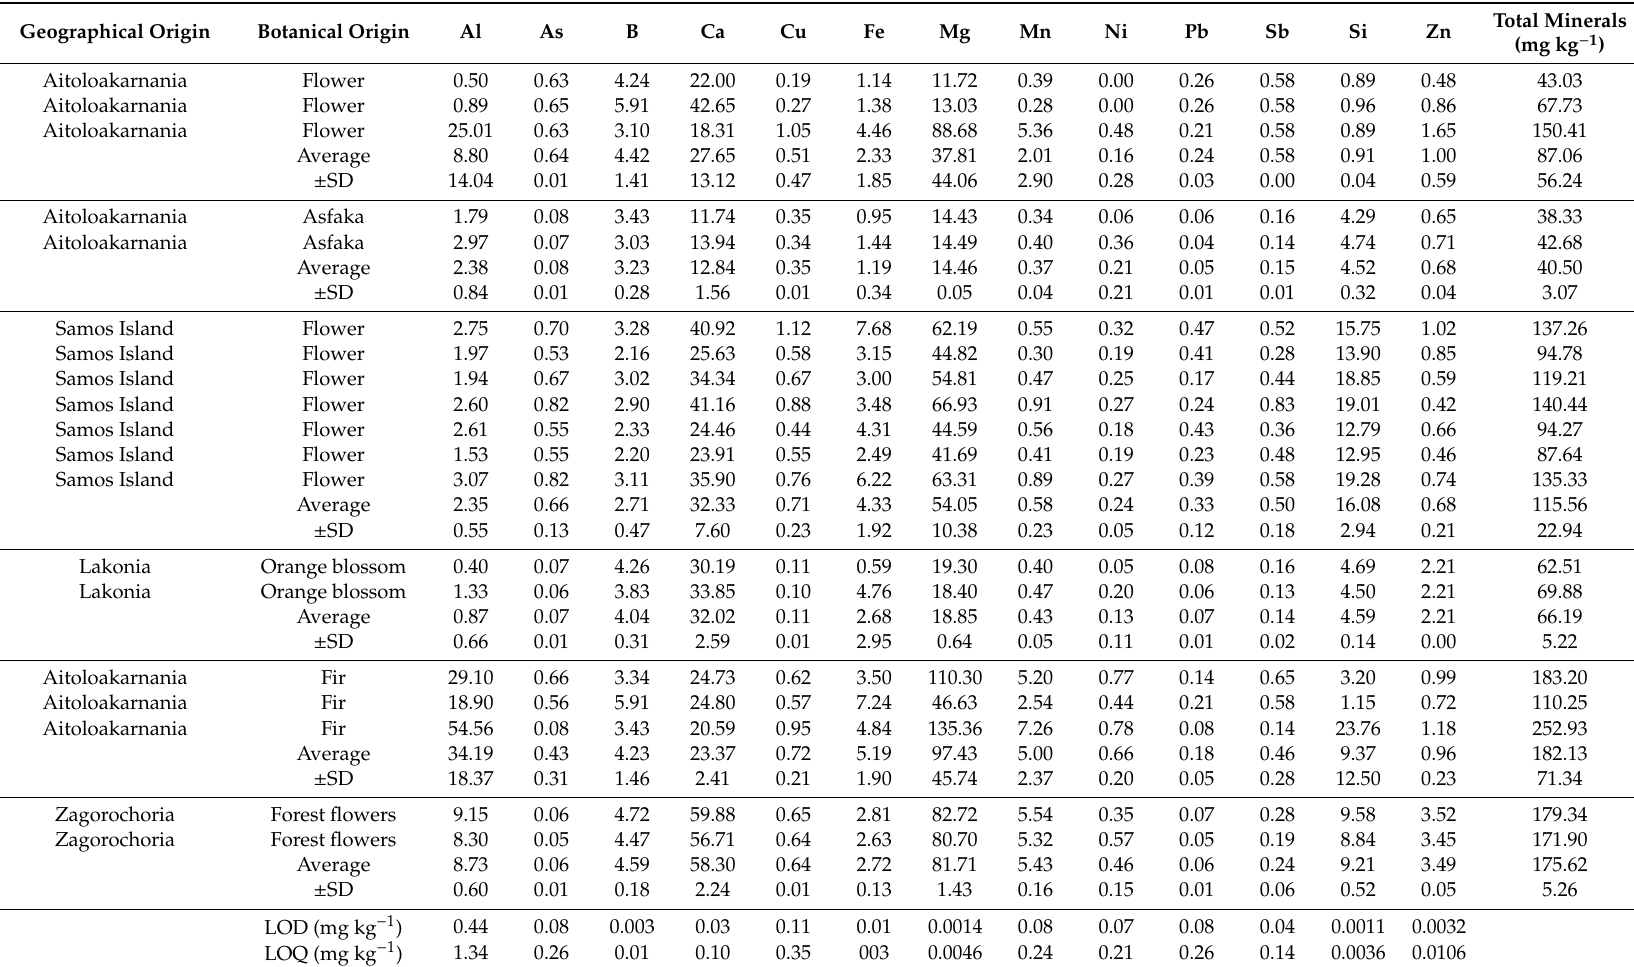
Table 1. Mineral content (mg kg − 1 ) of asfaka, cotton, fir, flower, forest flowers, and orange blossom